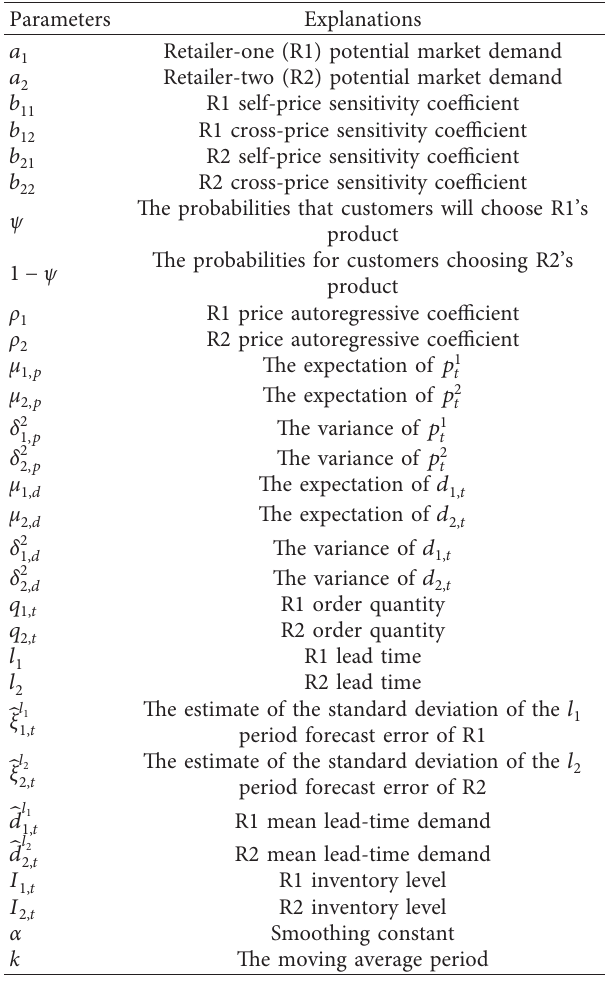
Table 1: Relevant parameters and